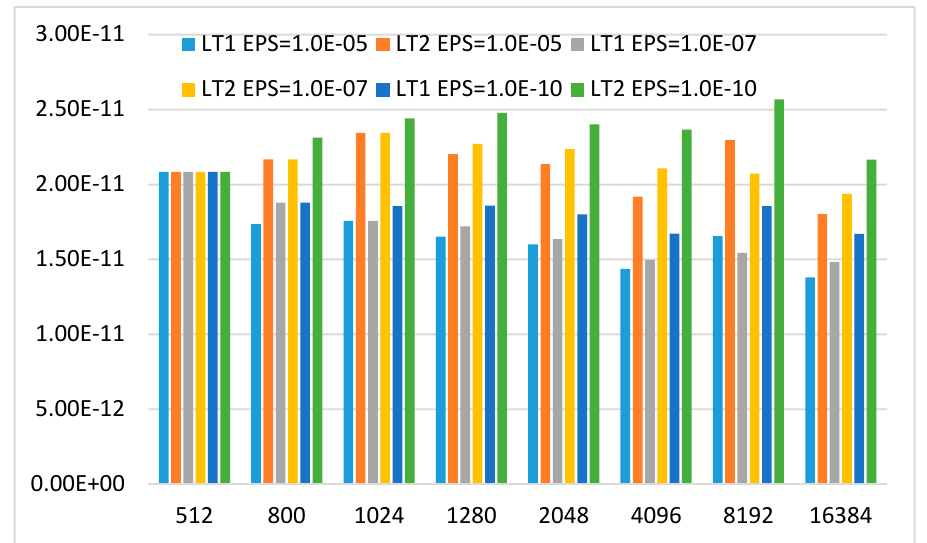
Figure 9. Computational time scaled by N log 4 N with CMAX = 64 (LT1 is the butterfly algorithm and LT2 is the proposed method. EPS is desired precision in interpolative decomposition, CMAX is the number of columns in each sub-matrix on level 0).